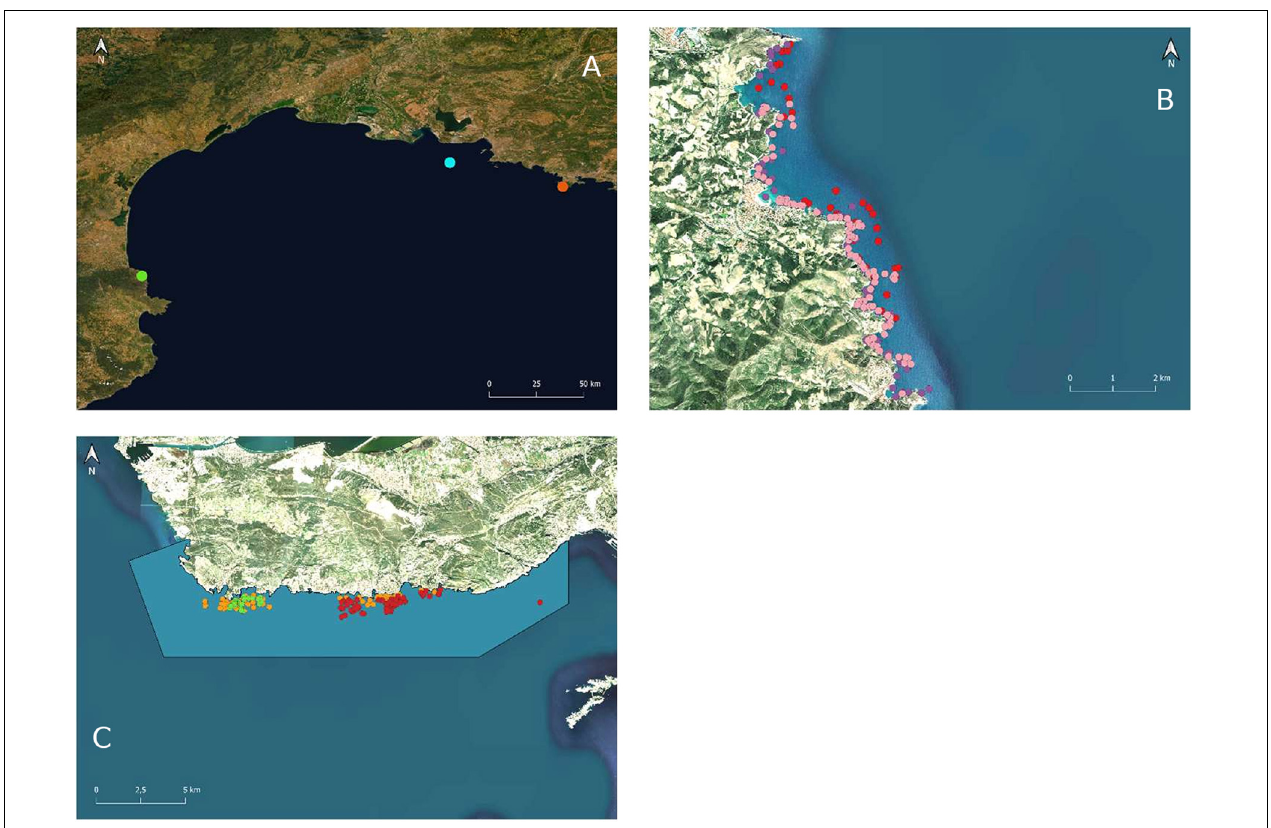
FIGURE 5 | Main sampled sites in the Mediterranean Sea (A) (Cerbère-Banyuls Natural Marine Reserve (green), and Côte Bleue Marine Park (light blue), and Sicié Cape (orange) and sampled stations at the two coastal MPAs surveyed with the protocol: (B) Cerbère-Banyuls Natural Marine Reserve and (C) Côte Bleue Marine